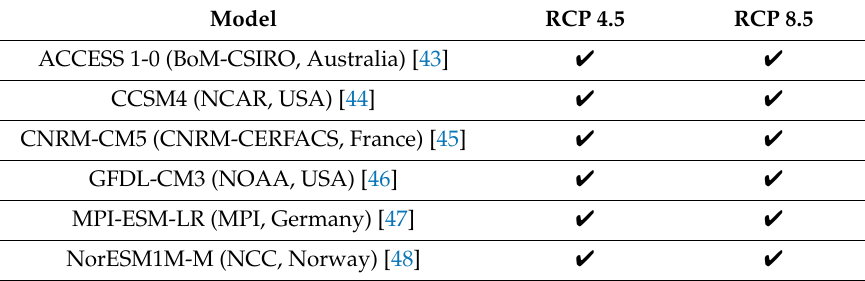
Table 1. List of ensemble members used in this study. RCP—Representative Concentration Pathway.